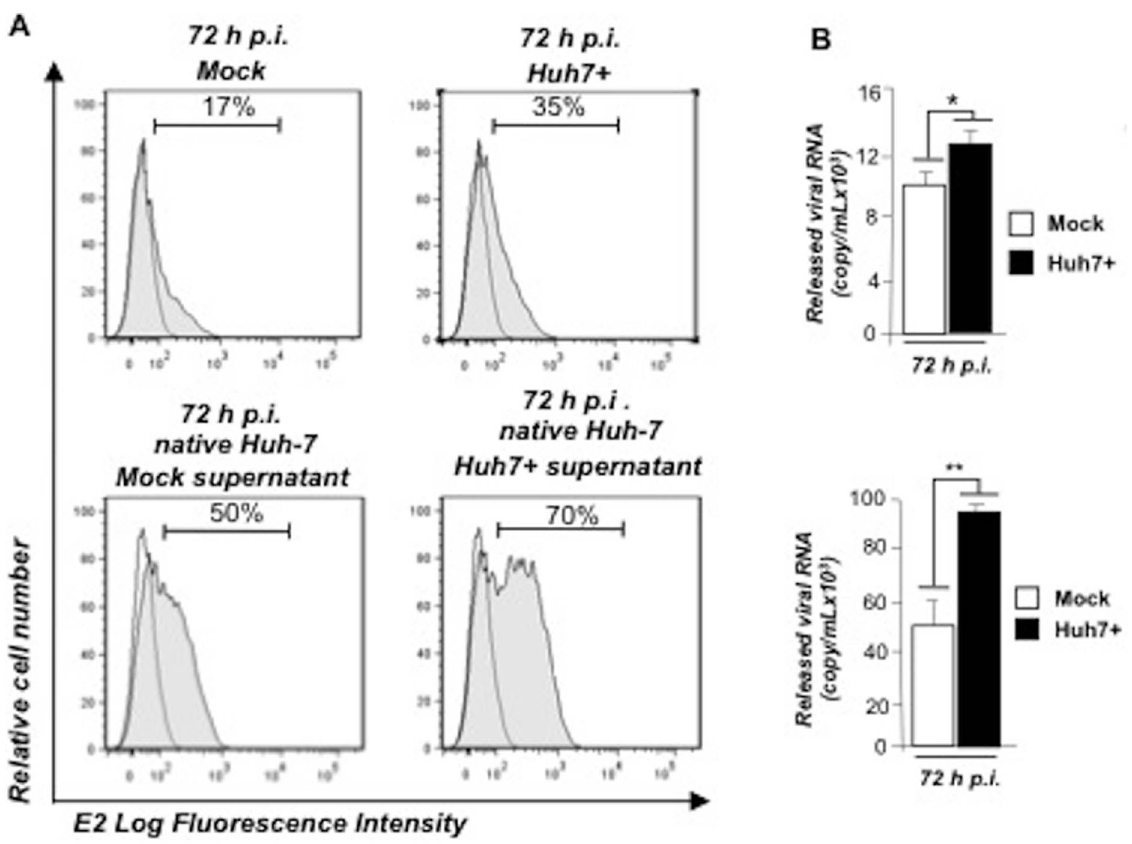
Figure 5. SLAMF3 over-expression increases the HCV infectivity. Mock and Huh7 + cells were challenged with HCVcc (A, top panel). (A) Supernatants were harvested at 72 h p.i., released viruses quantified by QPCR and equal viral loads from both supernatants were used to infect native Huh-7 cells (A bottom panel). (B) Viral replication was assessed by intracellular viral E2 protein expression measurement by flow cytometry and quantitation of released viral RNA at 72 h p.i. (mean of three independent experiments; error bars: SD *p , 0.05, **p , 0.01).